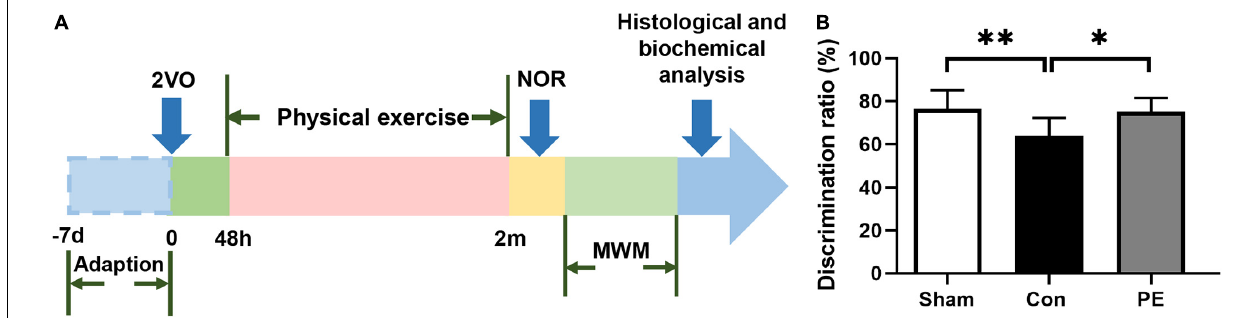
FIGURE 1 | Flow diagram of the experiment and the novel object discrimination ratio in rats with chronic cerebral hypoperfusion. (A) Flow chart of experimental design to explore the effect and mechanism of physical exercise on cognitive function in 2VO rats. 2VO, 2 vessel occlusion; NOR, novel object recognition; MWM, Morris water maze. (B) The novel object discrimination ratio of rats in each group. n = 10. Experimental data are expressed as the means ± SD. ∗ P < 0.05, ∗∗ P < 0.01. Con, control; PE, physical